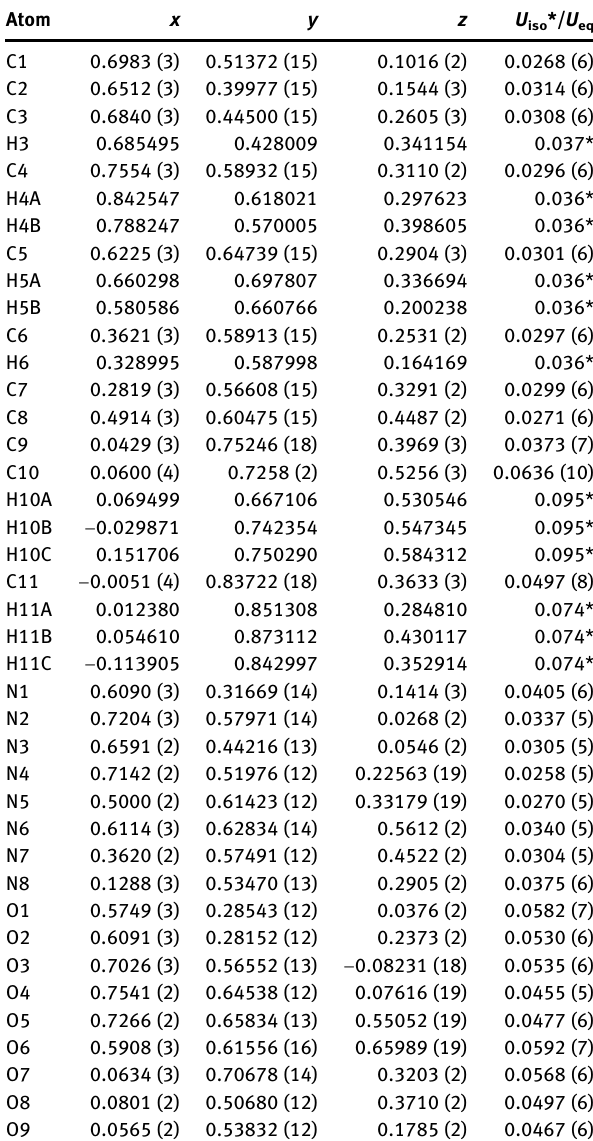
Table  : Fractional atomic coordinates and isotropic or equivalent isotropic displacement parameters (Å 